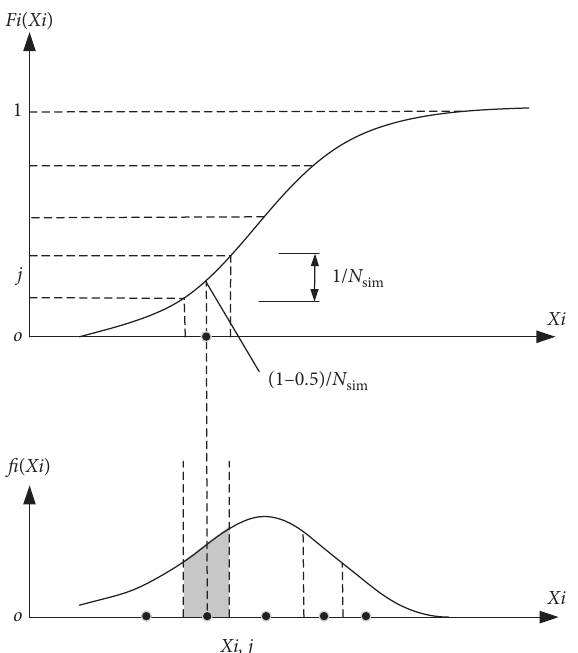
Figure 18: Schematic of one-variable